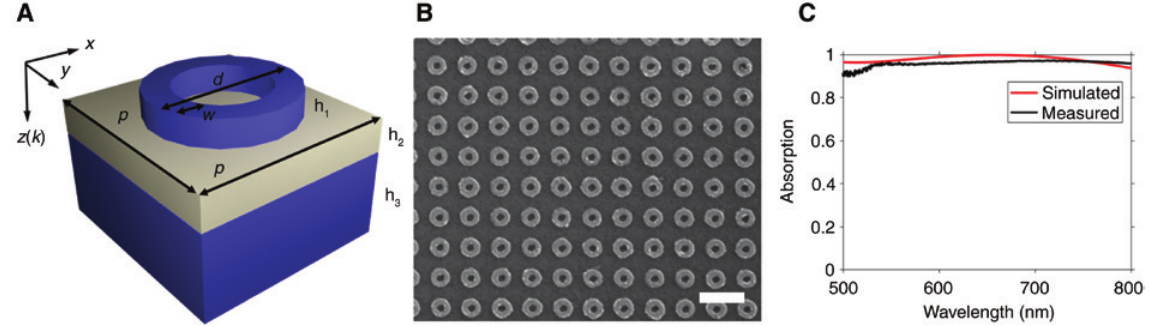
Figure 1: Cr absorbers. (A) Schematic of Cr absorber unit cell with dimensions of p = 300 nm, w = 40 nm, d = 160 nm, h Cr; gray, silica. (B) Scanning electron microscopy (SEM) image of the fabricated device. Scale bar, 500 nm. (C) Simulated and measured absorption